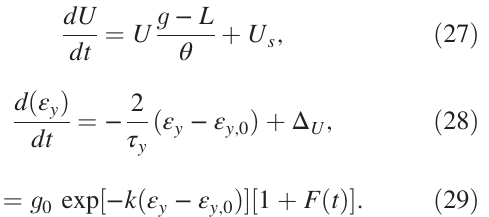
FIG. 10. Plot depicts the degradation of electron emittance ε due to FEL gain within a single oscillator pulse. Initially, the low emittance ε (red) enables a large positive gain (blue), which in y turn exponentially amplifies the x-ray power (dashed gray; vertical scale not shown). The increasing x-ray power degrades ε due to the TGU-FEL interaction. Near saturation, emittance ε y has increased so much that gain falls below zero, leading to the exponential decay of the x-ray